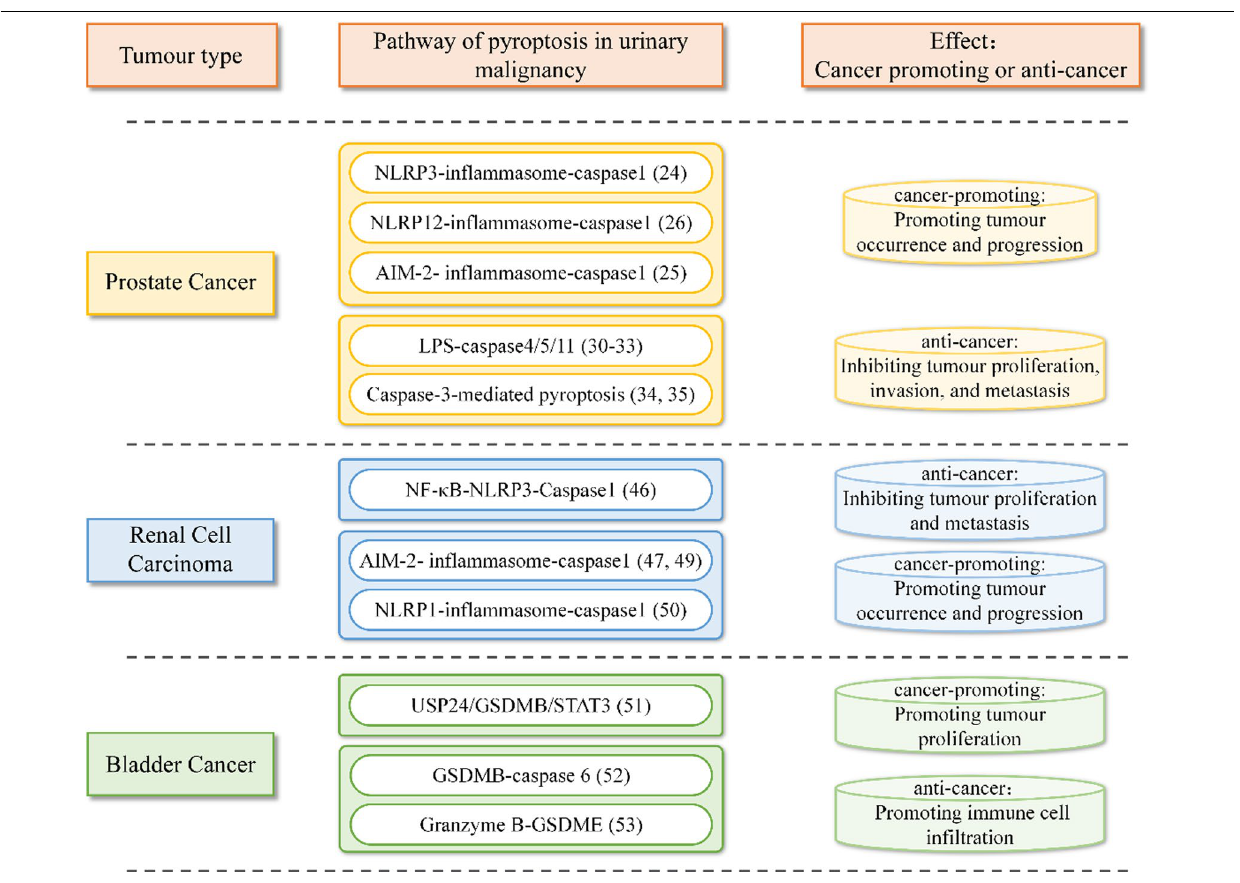
Table 1. The pathway and effect of pyroptosis in urinary